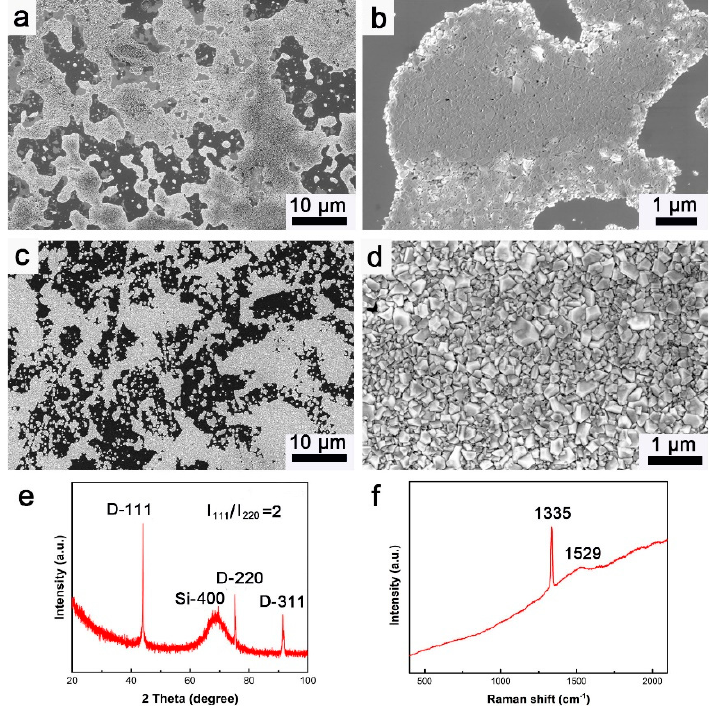
Figure 3. SEM images of the pre-seeded diamond nano-sheets on silicon surface at ( a ) low and ( b ) high magnifications; SEM images of the as-deposited diamond on the silicon surface at ( c ) low and ( d ) high magnification; ( e ) XRD pattern and ( f ) Raman spectrum of the as-deposited diamond on the silicon surface.